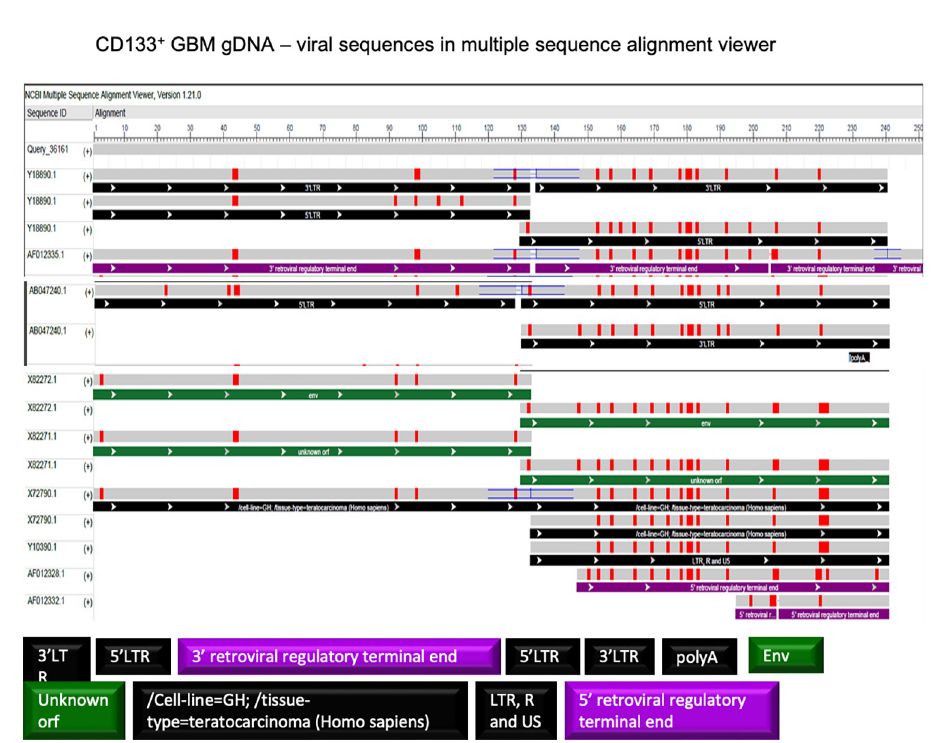
Fig 13. Analysis of the NSC and CD133 + GBM-gDNA clone. Detection of viral identities using Multiple Sequence Alignment Viewer 1.21.0.